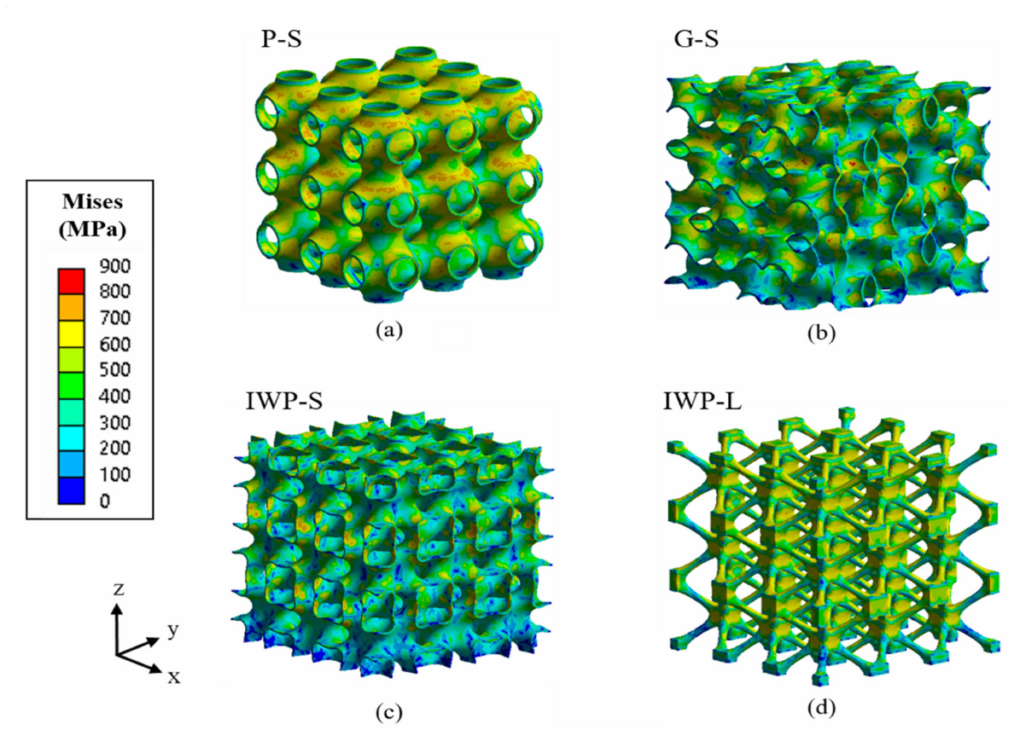
Figure 10. Von Mises residual stress field in the TPMS lattices build of ρ = 10%: ( a ) P-S, ( b ) G-S, ( c ) IWP-S, and ( d )